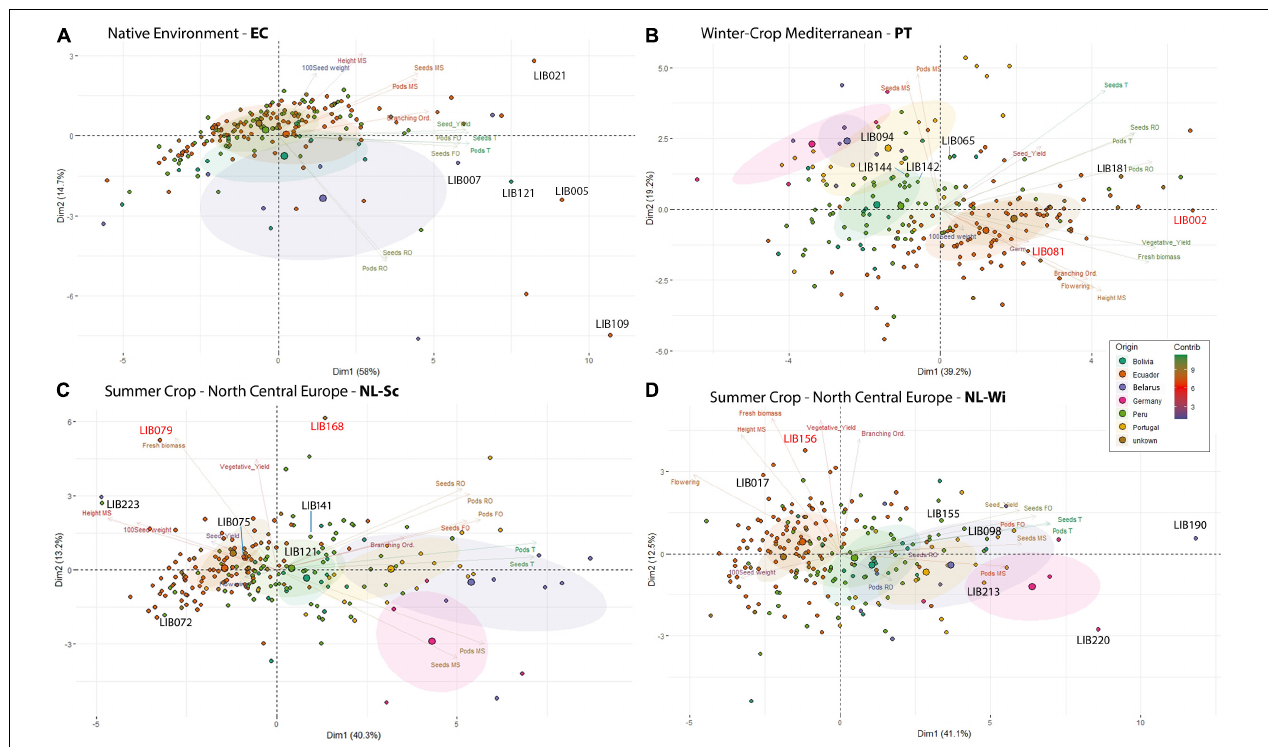
FIGURE 3 | Principal component analysis of L. mutabilis collection, including 201 lines from the INIAP gene bank (Bolivia, Ecuador, Peru, unknown, and Belarus), Andino, and 24 lines from breeding programs in Europe (Germany and Portugal). Each biplot shows the PCA scores of the explanatory variables (as vectors) and individuals (as points) separately for each of the environments tested: (A) Ecuador, (B) Portugal, (C) NL-Sc and (D) NL-Wi. Individuals on the same side as a given variable should be interpreted as having a high contribution to it. The color of the explanatory variables (vectors) shows the strength of their contribution to each PC. The five most high-yielding genotypes for each location are indicated on the graph with a black label. The accessions with the higher biomass yield in European trials are indicated in red (reported in Table 4